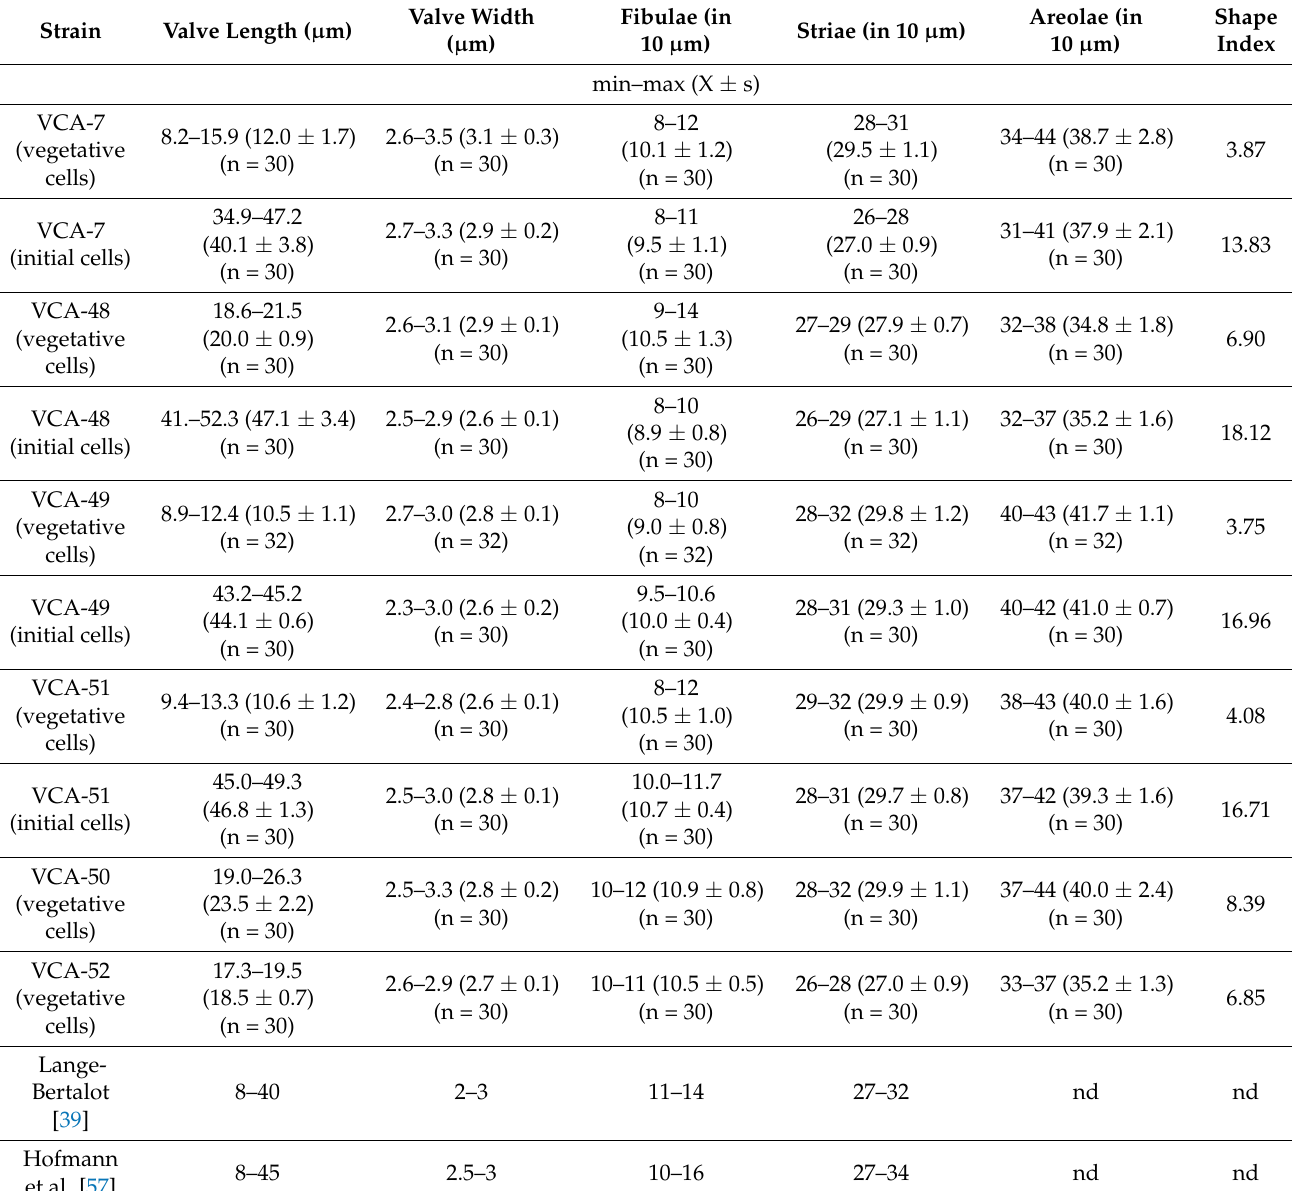
Table 1. Morphometric characteristics of N. acidoclinata observed in our strains and described in the